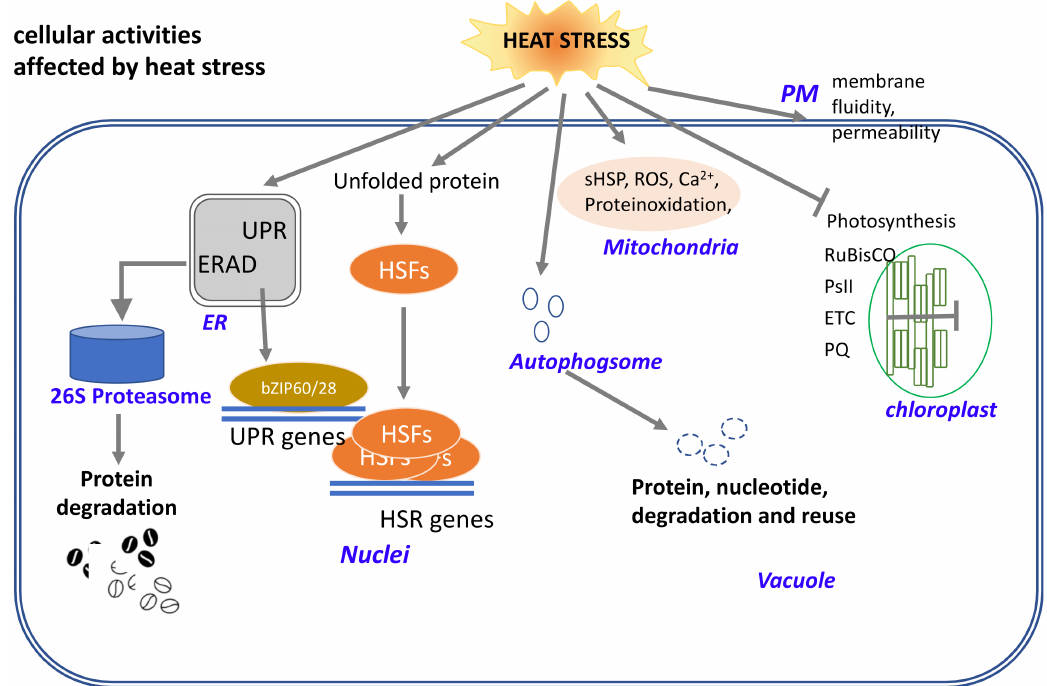
Figure 3. Schematic diagram illustrating the plant response to heat stress at the cellular level. Cell components, including nuclei, chloroplasts, mitochondria, and others, have their own acclimation when subjected to elevated temperatures. HSR in the nuclei/cytoplasm, UPR, and ERQC in the ER, photosynthesis in the chloroplasts, and other cell organelles in response to heat stress are